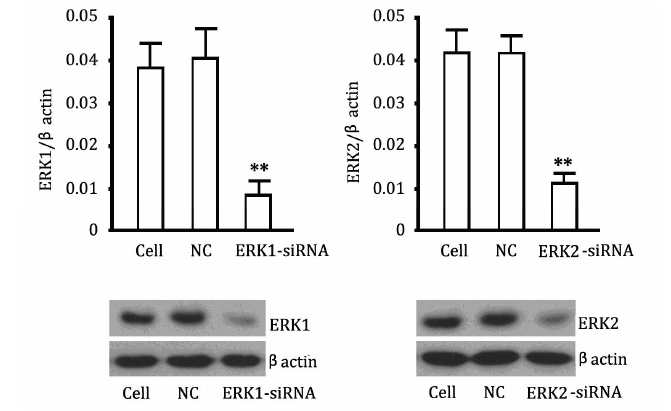
Figure 3. Knockdown of ERK1/2 by siRNAs. ( Upper ) Measurements of ERK1 and ERK2 expression levels in PEVCs (Pulmonary Vascular Endothelial Cells) by QRT-PCR; ( Lower ) Detection of ERK1 and ERK2 expression levels in PEVCs by western blotting. The negative control (NC) had no a interference. ** p < 0.01, vs.